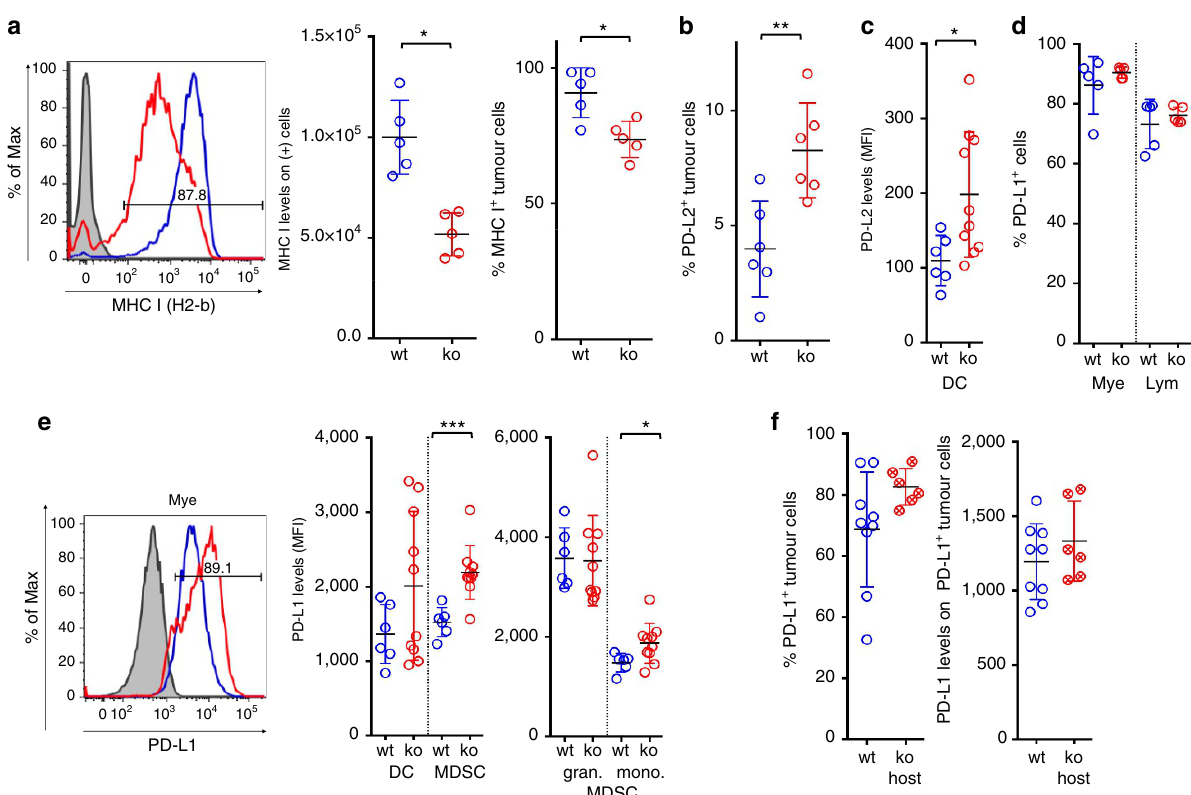
Figure 4 | Outgrowing tumours lacking PD-L1 apply various putative escape mechanisms. Flow cytometry analysis of MC-38 tumours indicated that PD-L1-deficient tumours contained fewer MHC-I positive tumour cells and reduced MHC-I surface expression levels ( a ), increased frequency of PD-L2 expressing tumour cells ( b ), and PD-L2 levels on myeloid dendritic cells (DC) ( c ). Although the percentage of PD-L1 positive myeloid and lymphocyte populations were unchanged ( d ), PD-L1 levels were notably increased in monocytic myeloid derived suppressor cells (MDSC) isolated from PD-L1-deficient tumours ( e ). PD-L1 levels on wild-type MC38 tumour cells remained high when implanted in wild-type or PD-L1-deficient hosts ( f ). Data shown is from wt MC-38 tumours in PD-L1-deficient host (crossed circles) or PD-L1-deficient MC-38 tumours in wt host (open circles), with PD-L1 wt status represented in blue and PD-L1 deficiency (ko) represented in red. Characterization of immune subsets by flow cytometry in in vivo tumours was performed at day 24 post-inoculation. Statistical significance was determined by Student’s t -test (* P o 0.05; ** P o 0.01, *** P o 0.001). Error bars depict s.d. from the